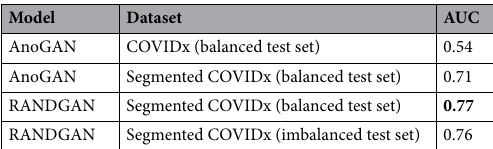
Table 2. Performance comparison of RANDGAN and